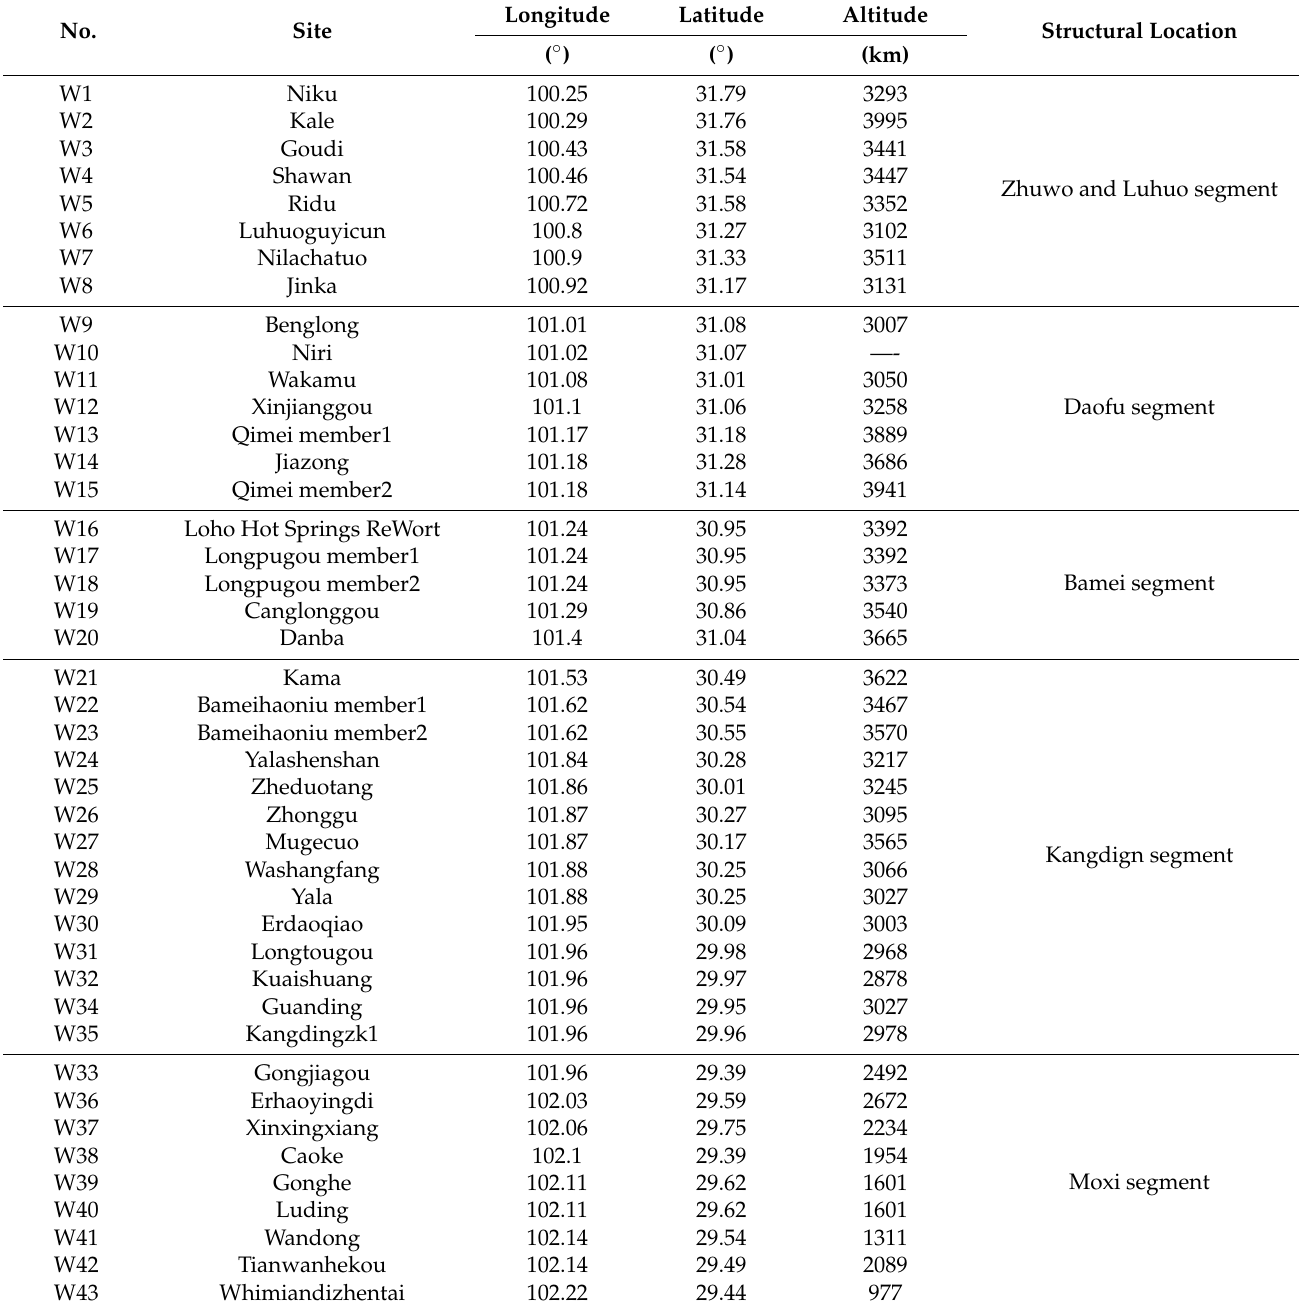
Table 1. Location of the surveyed area of hot spring in the